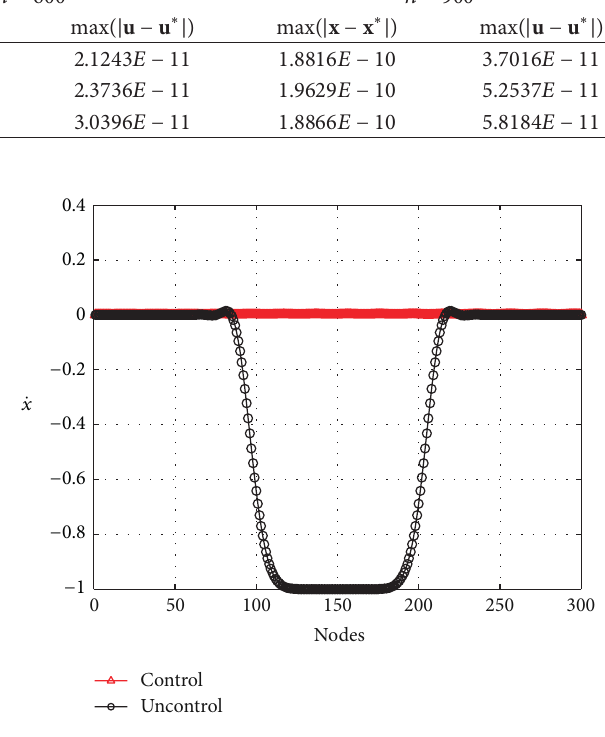
Figure 4: Displacement responses of all masses at 1000 sec with and without FMPC.